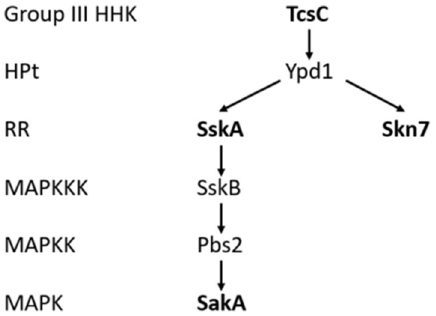
Figure 1. Schematic representation of the HOG pathway in A. fumigatus . Proteins that were characterized in this study are indicated in bold letters. Group III HHK = group III hybrid histidine kinase, HPt = histidine- containing phosphotransfer protein, RR = response regulator, MAPKKK = mitogen-activated protein kinase kinase